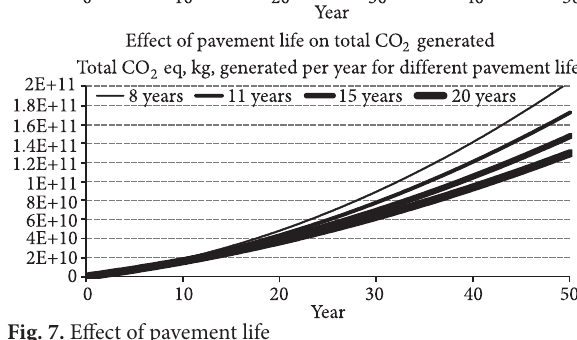
Fig. 7. Effect of pavement life